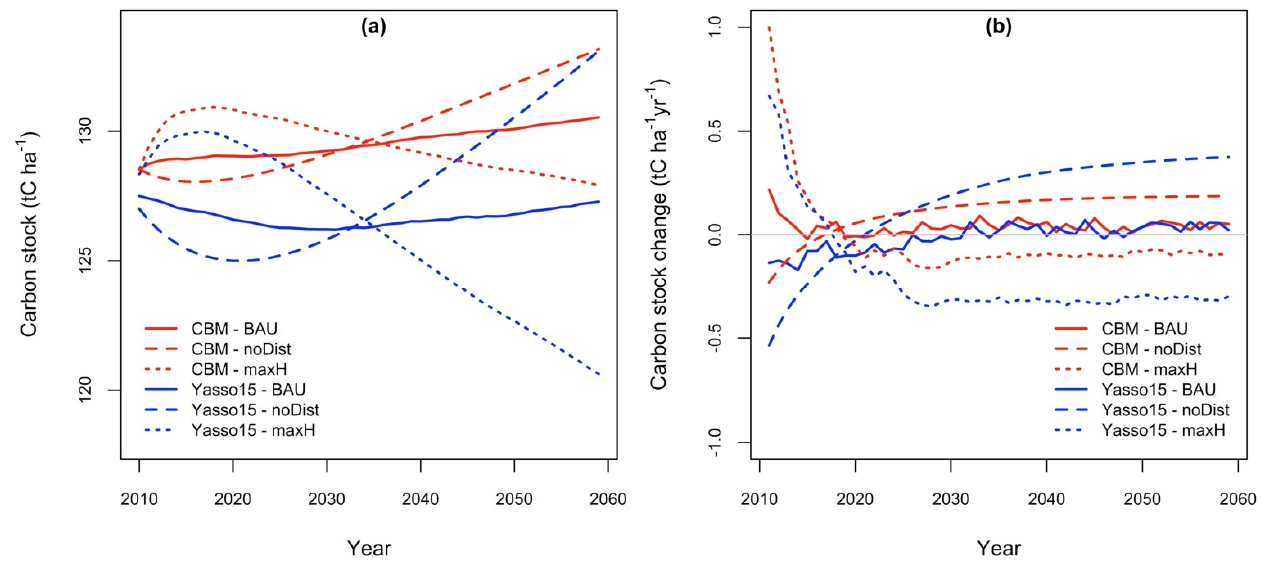
Figure 8. Total C stock in the dead organic matter pools, averaged for all forest types ( a ) and annual change ( b ) in total C stock, corresponding to the three scenarios. The values are averaged for all eight forest types.